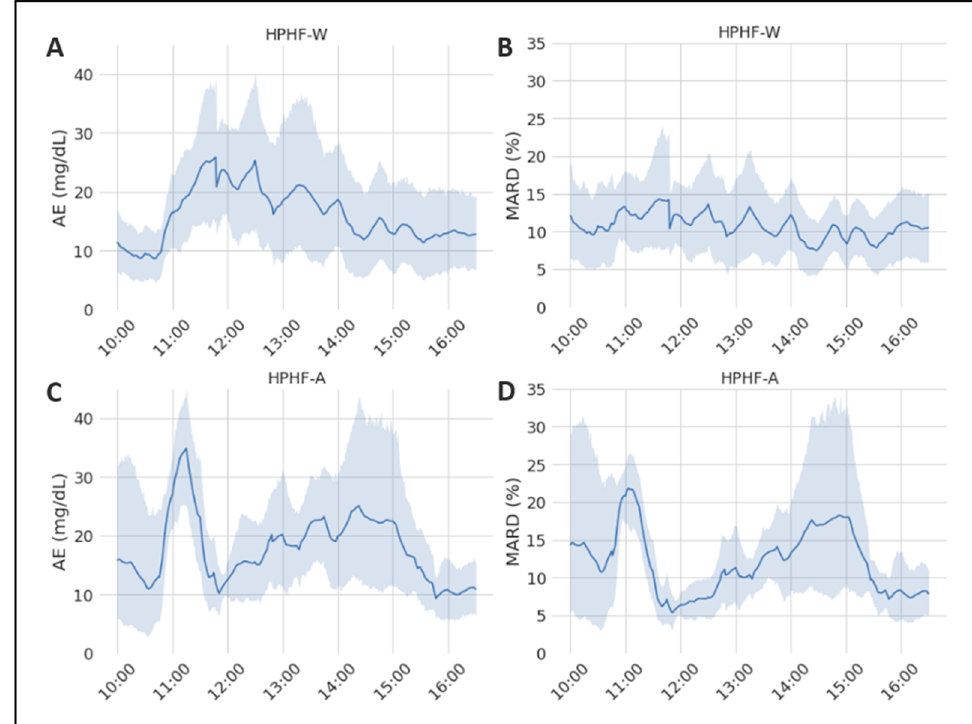
Figure 1. Representation of the mean values of the considered sensor-accuracy metrics during the study duration. The grey area represents the 95% CI. ( A ) Evolution of the AE during the HPHF-W study; ( B ) evolution of the MARD during the HPHF-W study; ( C ) evolution of the AE during the HPHF-A study; ( D ) evolution of the MARD during the HPHF-A study.